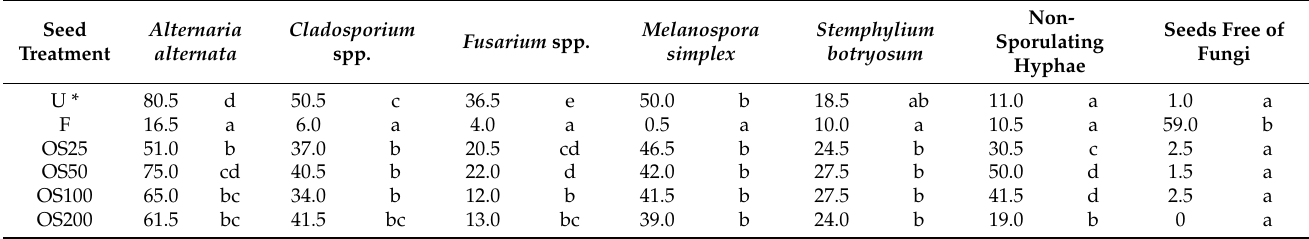
Table 3. Effects of osmopriming with the addition of melatonin on the incidence of fungi on D. carota ‘Amsterdamska’ seeds of sample I and seeds free of fungi (%).